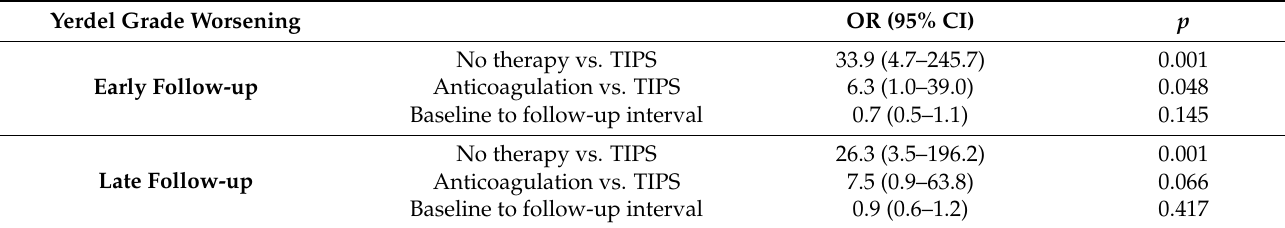
Table 3. Univariate ordinal logistic regression analysis of Yerdel grade worsening. Yerdel Grade